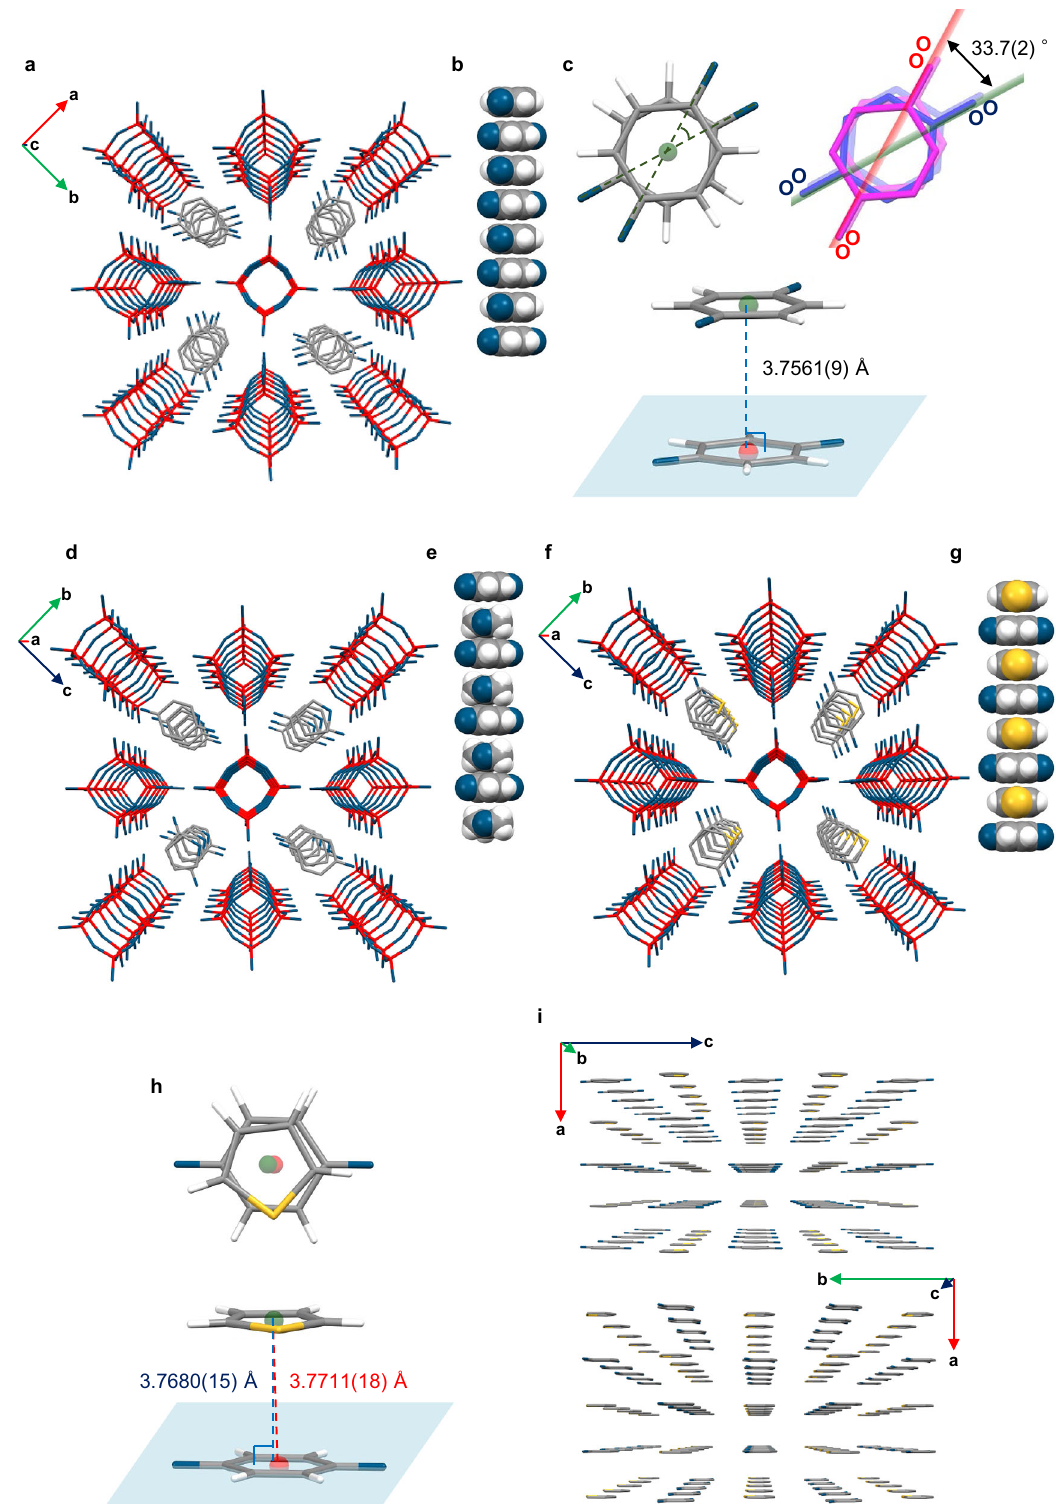
Fig. 7 Crystal structures of 3D crystals encapsulating p -benzoquinone. Crystal structures of 3D ⊃ p -benzoquinone ( a – c ), 3D ⊃ THF· p -benzoquinone ( d , e ), and 3D ⊃ thiophene· p -benzoquinone ( f – i ) determined by single-crystal X-ray diffraction. The orientation of the guest molecules in 3D ⊃ THF· p -benzoquinone and 3D ⊃ thiophene· p -benzoquinone was disordered, and a representative orientation is shown for clarity. The hydrogen atoms in the 3D crystal packing representations have been omitted for clarity. Color code: Si = red; O = blue; C = gray; H = white; S = yellow. The green and red points are the centroids of the guest molecules, and the light blue plane passes through a guest molecule. The dashed line color scheme is as follows: twist angle: green; line connecting the centroids of two guests: red; line vertically connecting a centroid to the molecular plane of another guest: blue. a , d , f 3D crystal packing; b , e , g partial space- fi lling views of the stacked guest molecules; c , h top view and diagonal view of the geometry of the stacked guest molecules; i 3D crystal packing of guest molecules in the crystal of 3D ⊃ thiophene· p -benzoquinone with 1 omitted for